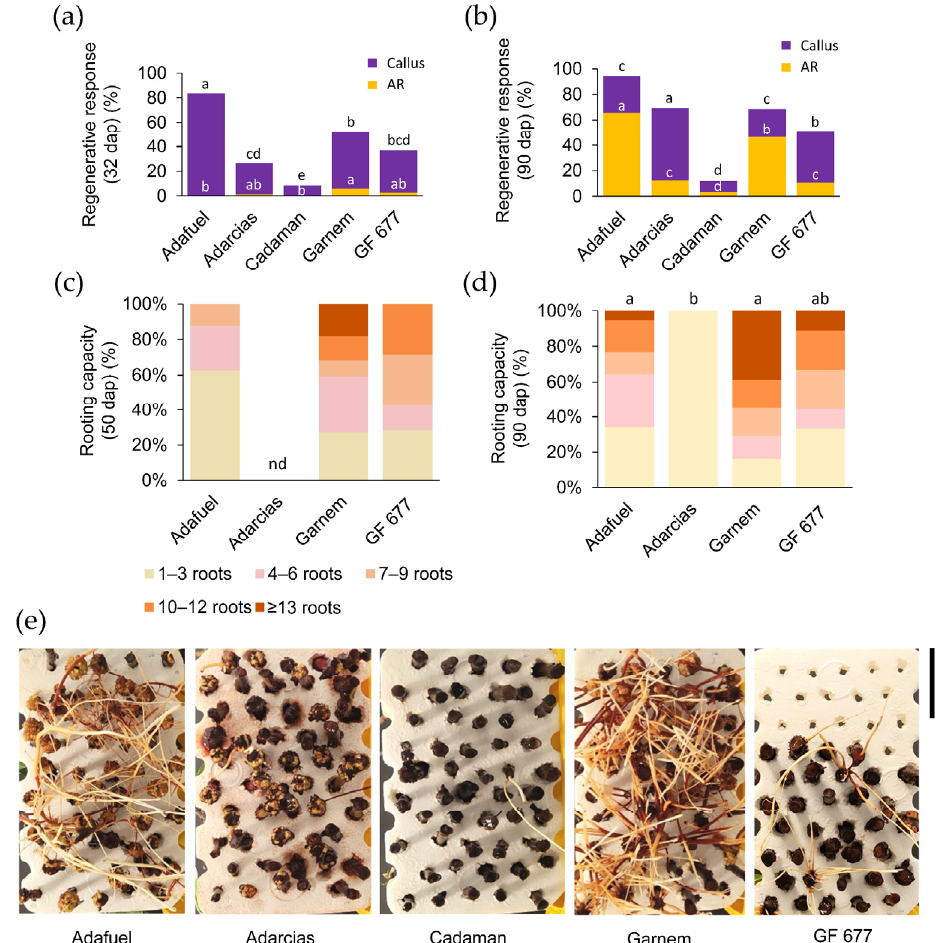
Figure 1. Rooting performance of hardwood cuttings of five Prunus rootstocks during hydroponic growth. ( a , b ) The regenerative response was estimated by the percentage of cuttings with callus and adventitious roots (ARs) at ( a ) 32 days after planting (dap) and ( b ) 90 dap. The number of samples varies from 59 to 72. Letters indicate significant differences ( p -value < 0.05; Chi-square) between genotypes in callus regenerative response, and white letters indicate significant differences ( p -value < 0.05; Chi-square) between genotypes in AR regenerative response. ( c , d ) Rooting capacity at ( c ) 50 and ( d ) 90 dap according to the indicated categories. Letters indicate significant differences ( p -value < 0.01) for the average number of ARs between the genotypes studied. The number of samples varies from 7 to 56. ( e ) Representative images of the genotypes studied after 90 days of growth in hydroponic culture. Scale bar: 7.5 cm.